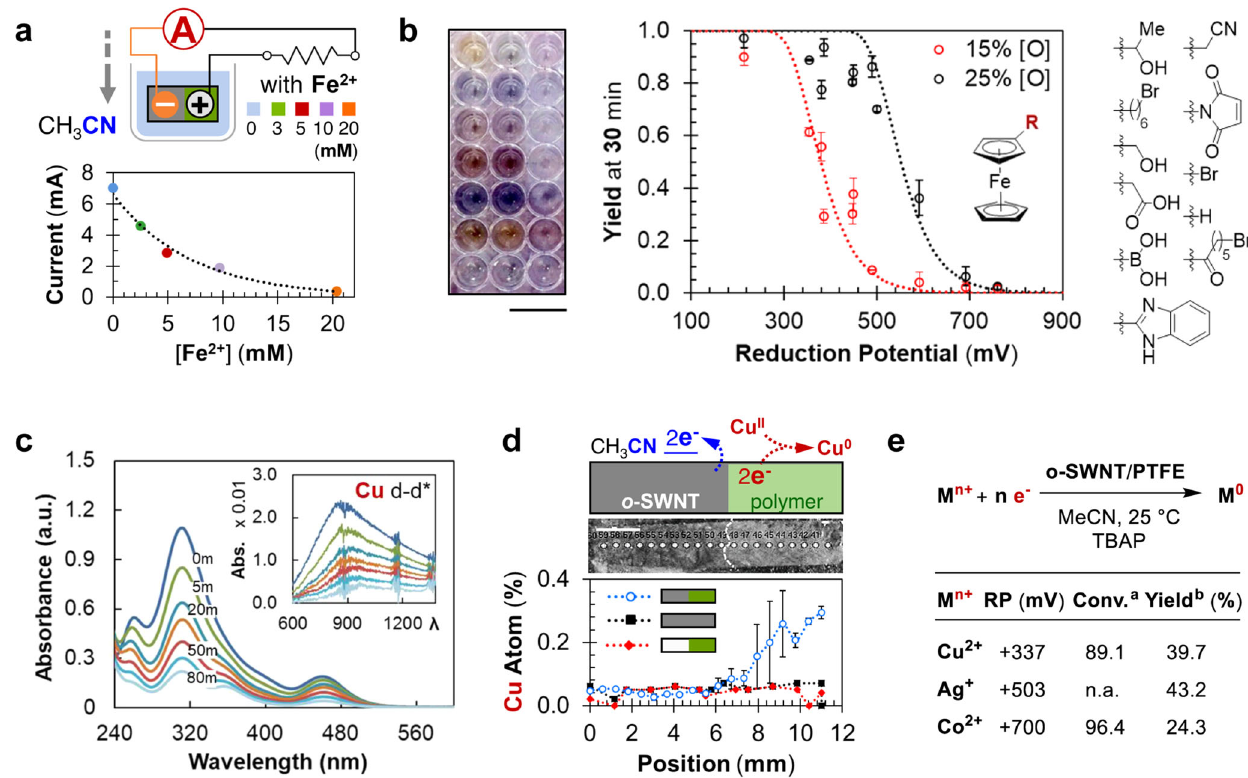
Fig. 3 Electrochemical characterization using various redox pairs. a Top: schematic illustration of closed-circuit current measurements upon inserting a particle generator (1 mm × 2 mm × 2 mm, AR = 4, volume = 4 mm 3 ) into various concentrations of ferrocene CH 3 CN solutions. b Left: optical image of 10 (in replica of two, so 20 total) parallel oxidation reactions using different ferrocene derivatives followed by a standard UV-Vis plate reader (scale bar, 1 cm). Right: calibrated yields of different ferrocene derivatives measured at 30 min of reaction time using o-SWNT/polymer particles at two SWNT oxidation levels (black: [O] = 25%, standard condition; red: [O] = 15%, as measured by XPS). These plate-reader-determined yields are ranked with the reduction potentials of these ferrocene derivatives, measured separately using cyclic voltammetry (see Supporting Information 8). Error bars represent standard deviations of the calibrated yields ( n = 4). c Real-time UV-Vis absorption spectra of a well-stirred copper chloride (CuCl 2 , 0.6 mM, in CH 3 CN) and TBAP (50 mM, in CH 3 CN) solution, upon insertion of one o-SWNT/polymer particle (1 mm × 2 mm × 2 mm, AR = 4). Inset: the absorption peak of the d – d transition of the copper (II) complex (Cu 2 + ). d Top: schematic illustration of the copper (II) reduction on the o-SWNT/polymer particle, showing the reduction is expected to take place on the polymer coating side. Middle: optical image of the 12 mm × 2 mm × 160 μ m (AR = 0.27, volume = 4 mm 3 ) o- SWNT/Na fi on device used, as viewed from the XPS vacuum chamber. Each spot represents a sampling point for X-ray excitation, with the Janus interface indicated by the dotted line (scale bar, 2 mm). Bottom: calibrated metallic copper (Cu 0 ) atomic percentage along the axial direction of the o-SWNT/ polymer Janus particle (blue) after Cu 2 + reduction reaction. Control particles of o-SWNT with no polymer coating (black) and Janus particles made with pristine-SWNTs (red) are also tested. Error bars represent standard deviation of XPS atomic ratio measurements using different samples prepared in separate reduction runs ( n = 3). e Reaction scheme, electrochemical reduction potentials 27 , conversions, and yields estimated for various metal ions. a The conversions are determined using UV-Vis absorption spectroscopy. b The yields represent lower bounds as estimated from XPS elemental mappings (see Supporting Information